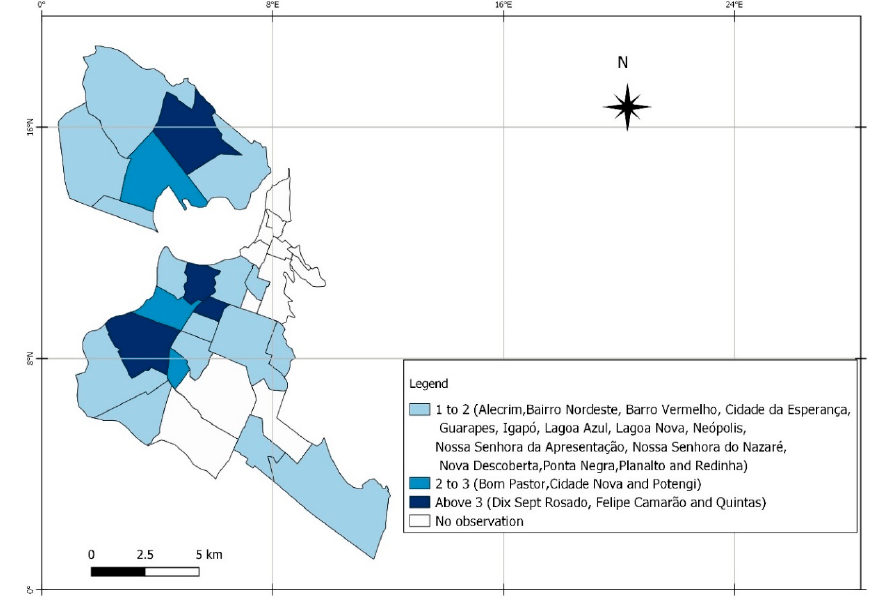
Figure 3. Distribution of partners who were not treated concurrently with pregnant women by location of residence in the municipality of Natal, Rio Grande do Norte, Brazil, from 2011 to 2015. A total of 129 pregnant women.